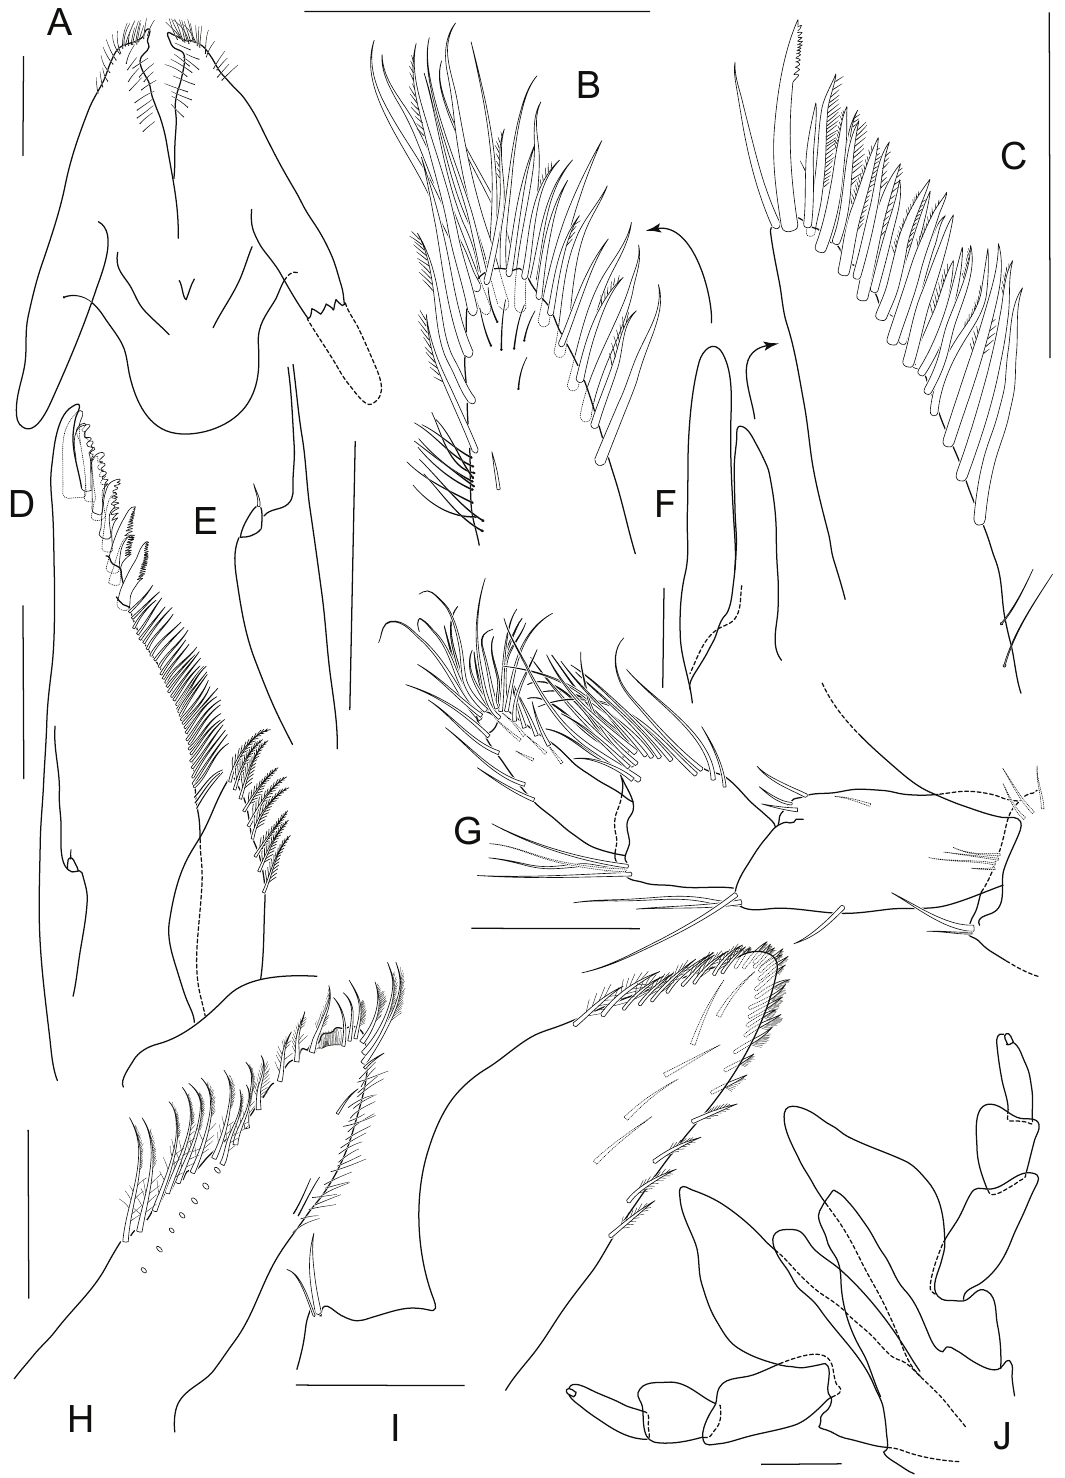
Fig. 8. Labriphimedia martinae nov. sp., holotype ♂, 6.5 mm, NIWA 84743. A . lower lip. B . Outer plate of maxilla 2. C . Inner plate of maxilla 2. D . left maxilla 1. E . Palp of right maxilla 1. F . Outlines of maxilla 2. G . Palp of maxilliped. H . Inner plate of maxilliped. I . Outer plate of maxilliped. J . Outline of maxillipeds. Scale bars: a-J = 100